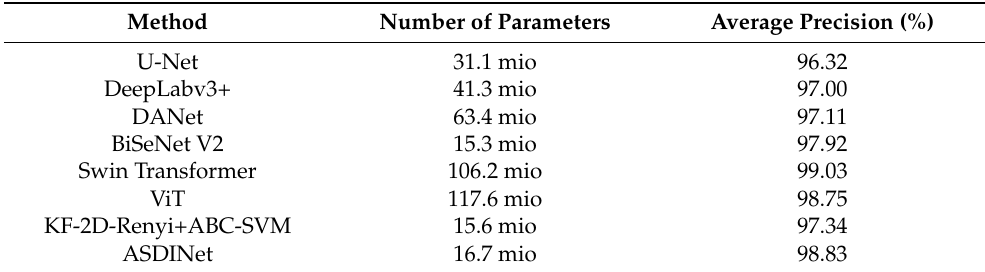
Figure 13. Detection (forward pass) time with respect to the classification performance for a single image. Table 12. Comparison with the state-of-the-art methods in the number of learnable parameters and average precision.